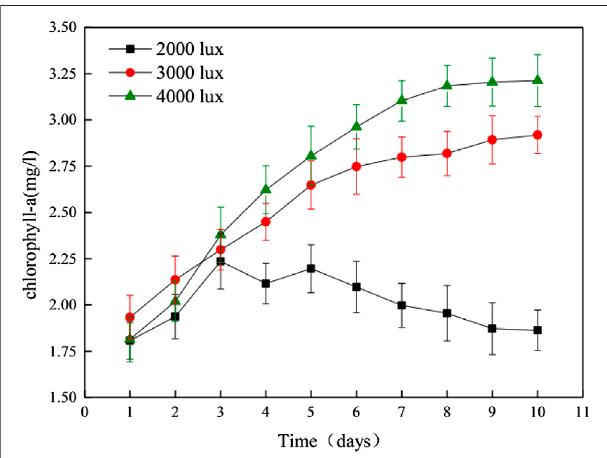
FIGURE 1 | Chlorophyll-a in different illumination